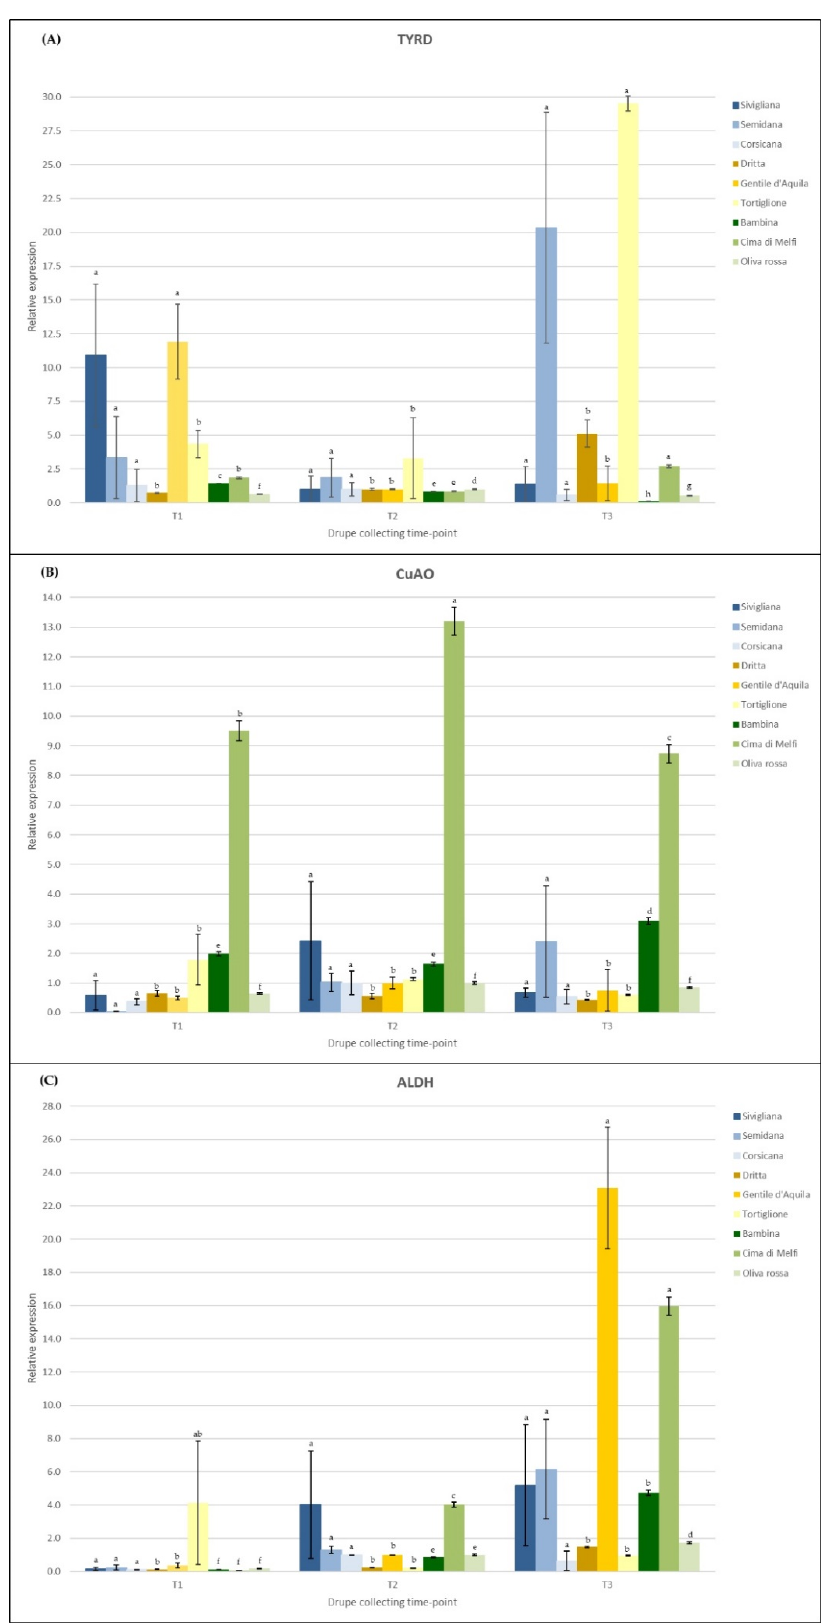
Figure 3. Expression profiles of the analyzed genes involved in the first step of the phenol biosynthetic pathway during fruit development (T1 = yellow-green drupes, T2 = turning drupes, T3 = almost